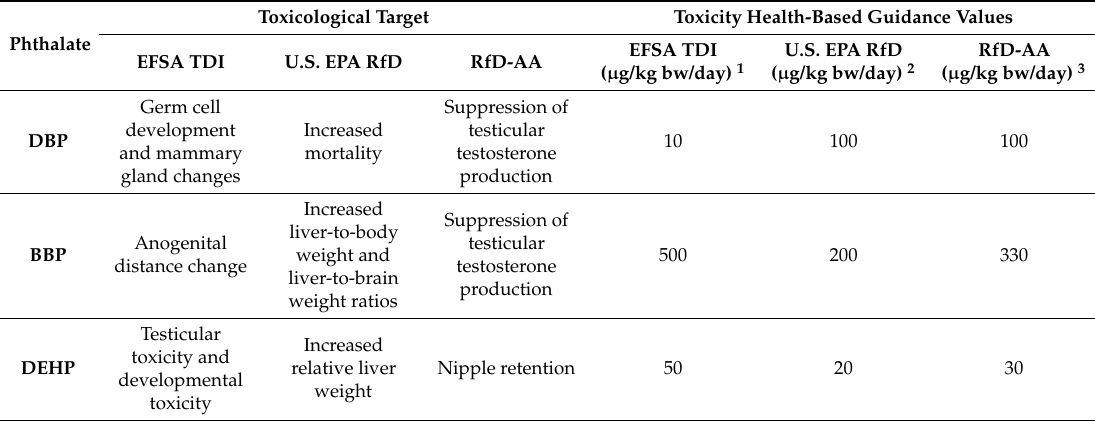
Table 2. Related health-based guidance values and toxicological target for dibutyl phthalate